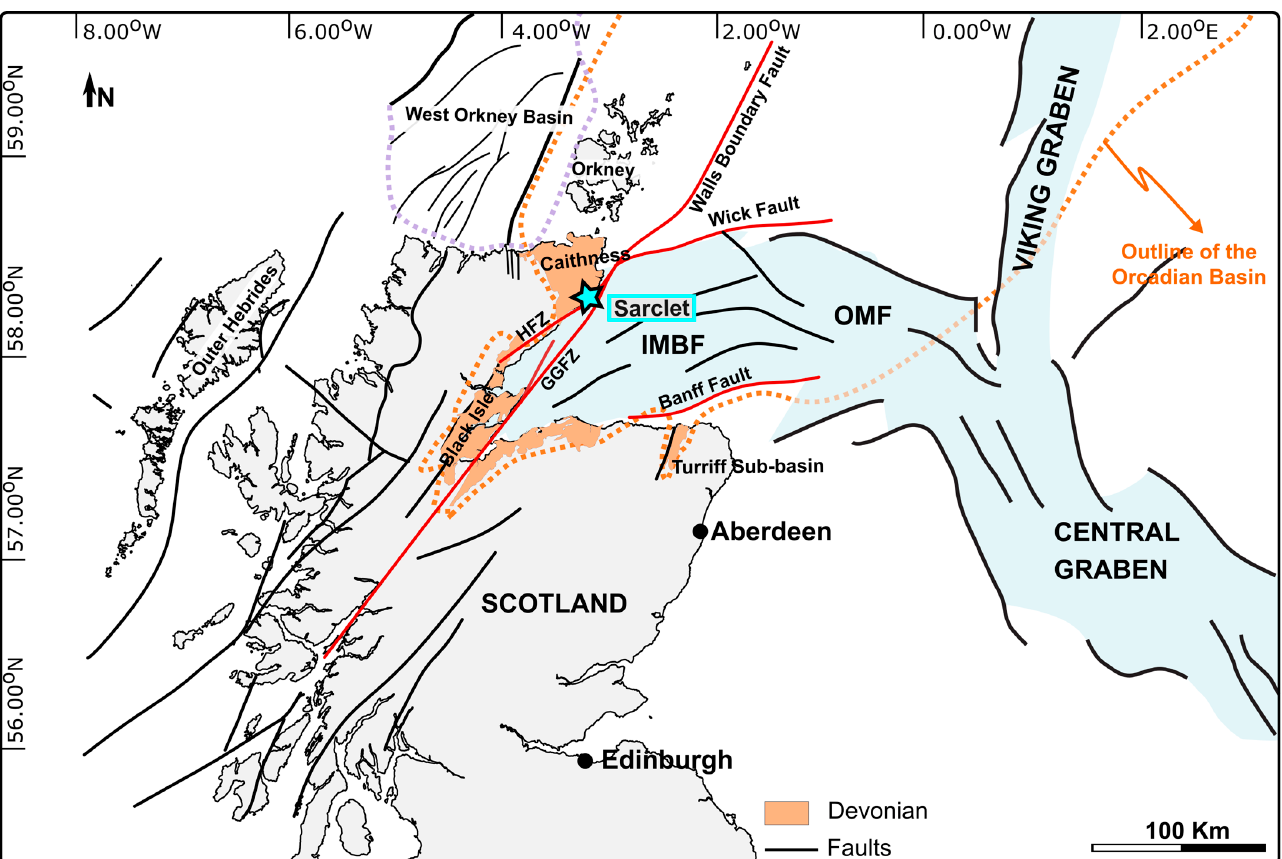
Figure 1. Generalised tectonic map of Scotland and the northern North Sea region showing the main Mesozoic rift systems (after [5]). The faults mentioned in the text are shown in red. GGFZ, Great Glen Fault Zone, HFZ, Helmsdale Fault Zone. Outline of the Orcadian Basin marked in dotted orange line, and outline of the West Orkney Basin is marked in dotted purple line.